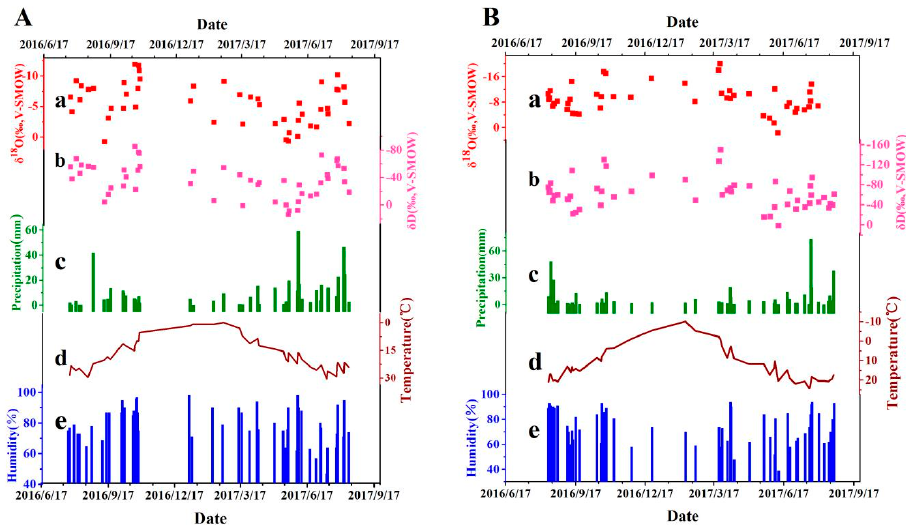
Figure 2. Seasonal variation of δ D, δ 18 O, and meteorological information of precipitation. ( A , B ) represent Fengxiang and Ningwu, respectively. ( a ) indicates individual precipitation δ 18 O (‰, V- SMOW); ( b ) indicates individual precipitation δ D (‰, V-SMOW); ( c ) indicates individual precipitation amount (mm); ( d ) indicates daily surface air temperature (°C); and ( e ) indicates daily surface air humidity (%).